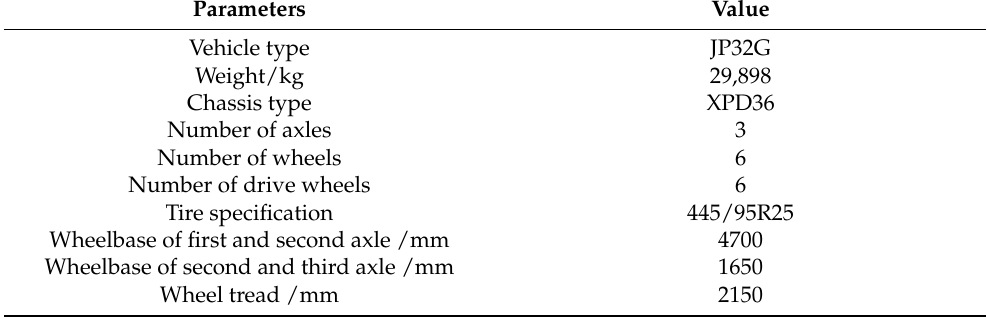
Table 4. Main parameters of the tested vehicle.